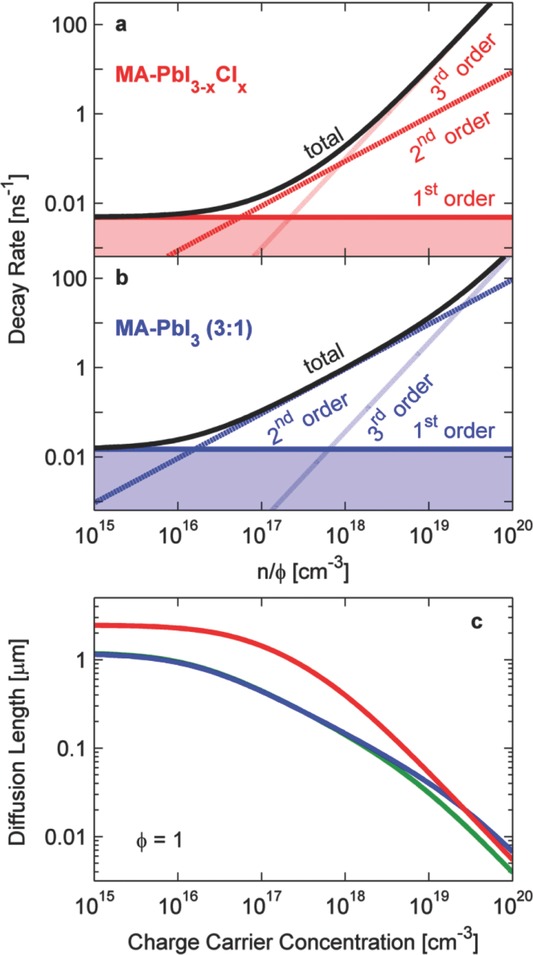
Charge-carrier decay rates and diffusion lengths of organolead trihalide perovskites as a function of charge carrier concentration, extracted from analysis of transient photoconductivity and photoluminescence measurements. a,b) Charge-carrier decay rates for CH3NH3PbI3−xClx and CH3NH3PbI3 (3:1) as a function of nφ, where n is the charge carrier density in the materials and φ the ratio of n to the absorbed photon density. Rates are computed from the rate constants determined in this work (see Table1). Plotted are the 1st (monomolecular, solid), 2nd (bimolecular, dashed) and 3rd order (Auger, dotted) contribution to the total decay rate (black, solid), where R1 = k1, R2 = φ k2 (n/φ), R3 = φ2k3 (n/φ)2 and Rtotal = dn/(ndt) is the sum total. c) Charge-carrier diffusion lengths L = (μkBT/(e Rtotal))1/2 for CH3NH3PbI3−xClx (red), CH3NH3PbI3 (3:1) (blue) and CH3NH3PbI3 (1:1) (green) as a function of charge-carrier concentration n, derived from charge-carrier decay rates and THz mobilities of 11.6 cm2 V−1 s−1, 8.1 cm2 V−1 s−1 and 8.2 cm2 V−1 s−1 (φ = 1).